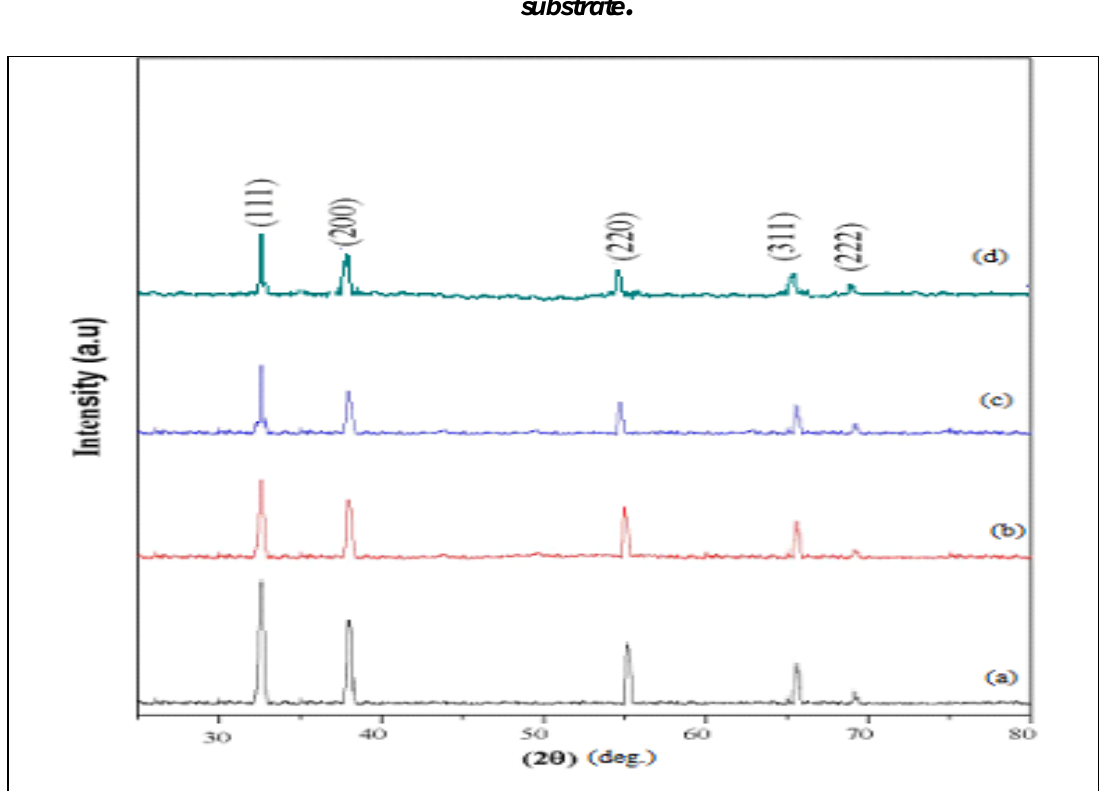
Fig. 2: XRD pattern of a) pure CdO films b) 2% Ce, c) 4%:Ce, and d) 6% Ce deposited on silicon